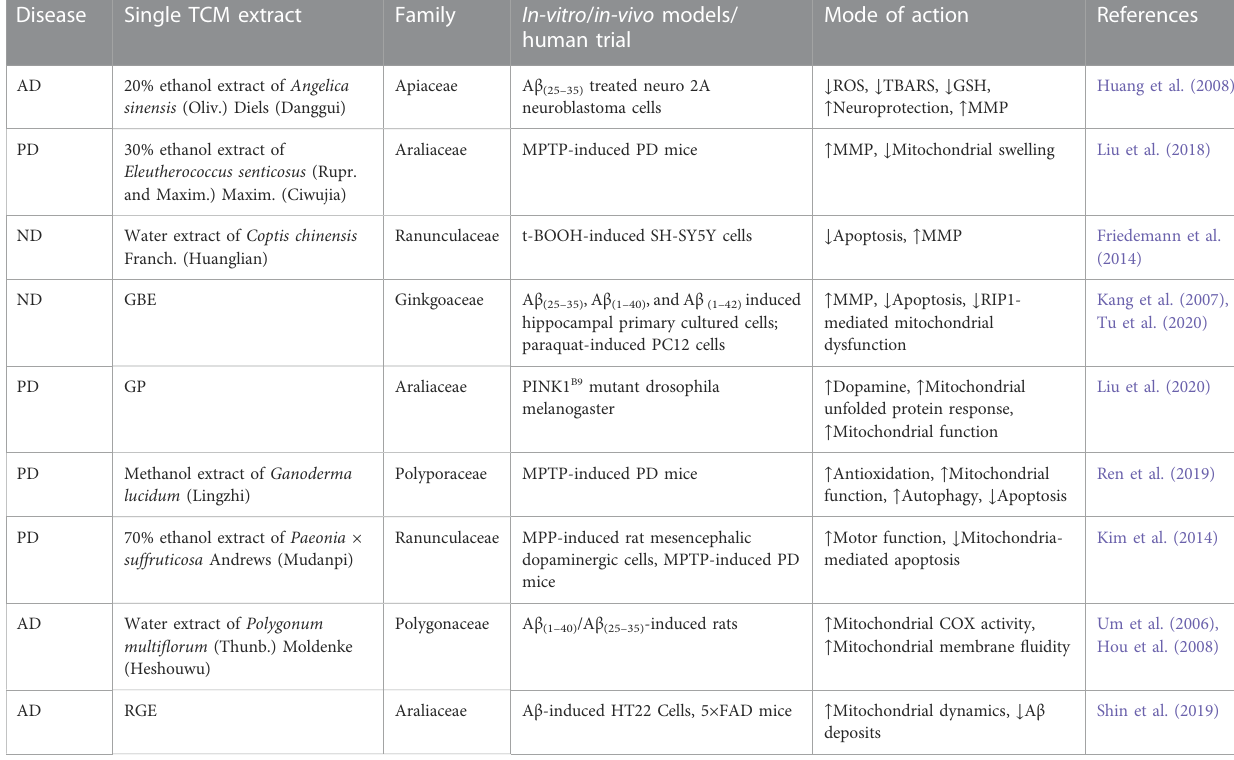
TABLE 2 List of standardized extracts from individual traditional Chinese medicines (TCMs) exerting anti-neurodegenerative disease (anti-ND) effects by modulating mitochondrial dysfunction.